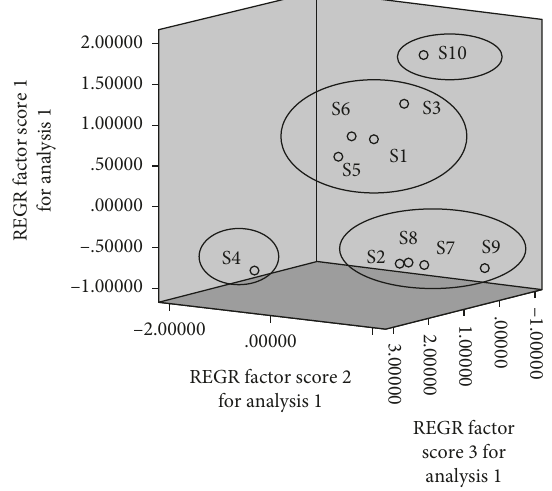
Figure 4: Cluster analysis results of fingerprints of 10 batches of ethyl acetate extracts from S spatulifolius . Table 6: Rotation component matrix.